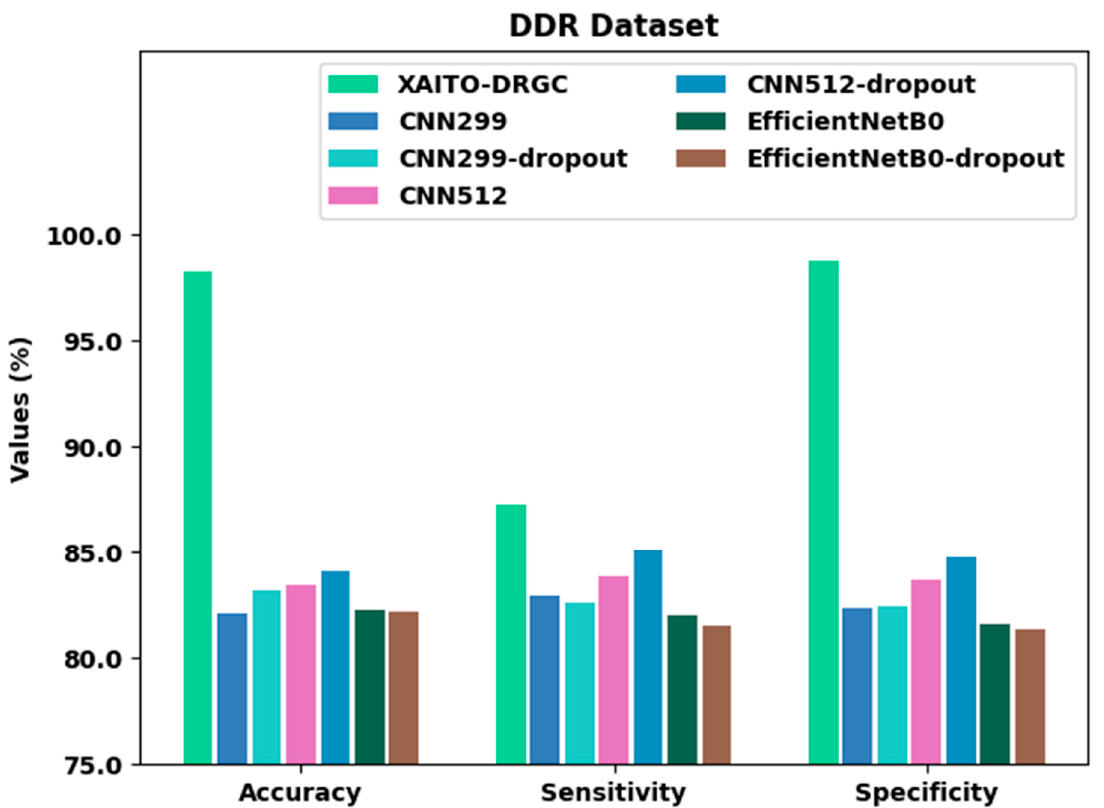
Figure 12. Comparative analysis of the XAITO-DRGC approach under the DDR dataset.